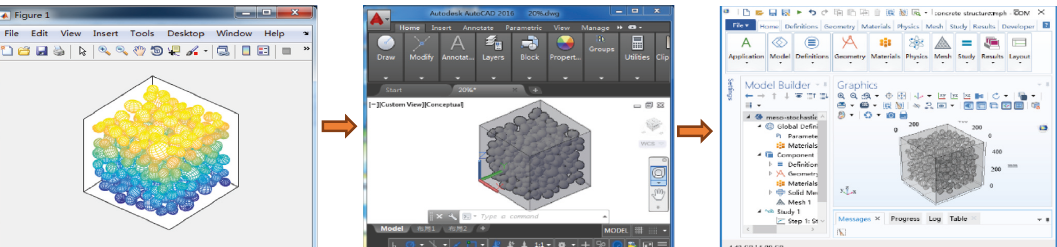
Figure 11: Format conversion method.